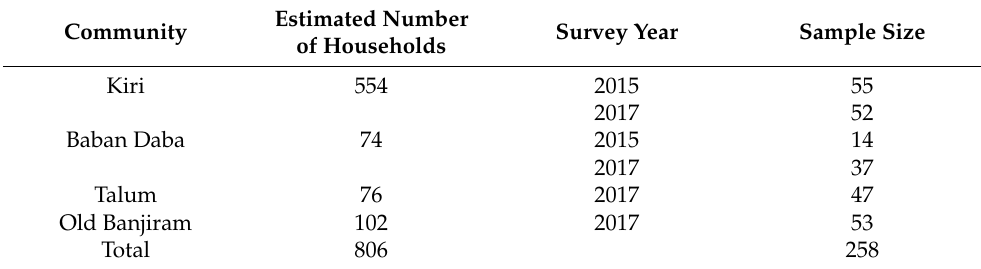
Table 2. Estimated number of households and final sample sizes for each community in this study.